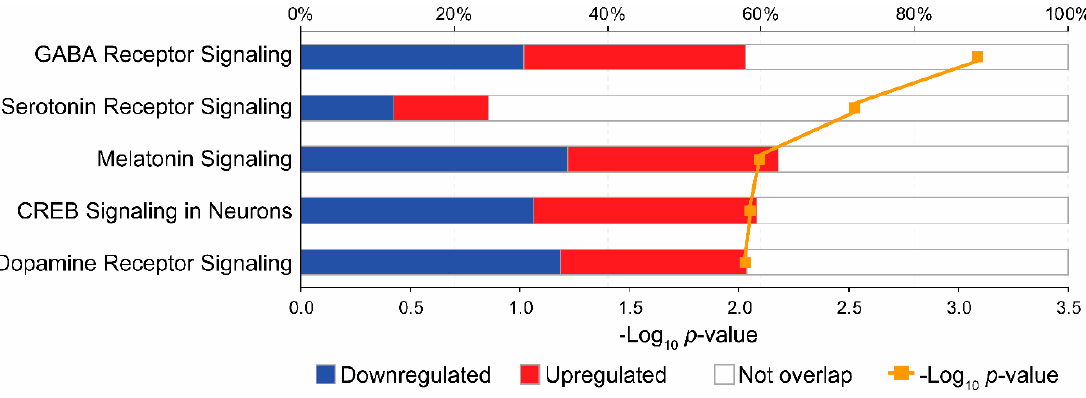
Figure 2. Top canonical enriched pathways identified by the Ingenuity Pathway Analysis software. This figure is based on proteins identified in the dataset of this study and their known associations across the pathways related to neurotransmitters and other nervous system signaling. The stacked bars indicate the percentage of proteins distributed according to regulation, i.e., blue (down), red (up), and open bars (no overlap with dataset) in each canonical pathway. The orange line represents the score for the likelihood that the proteins belonging to a specific canonical pathway, this is the “ p -value of overlap” of the proteins in our dataset relative to the Ingenuity Pathway Analysis (IPA)’s predefined categories.